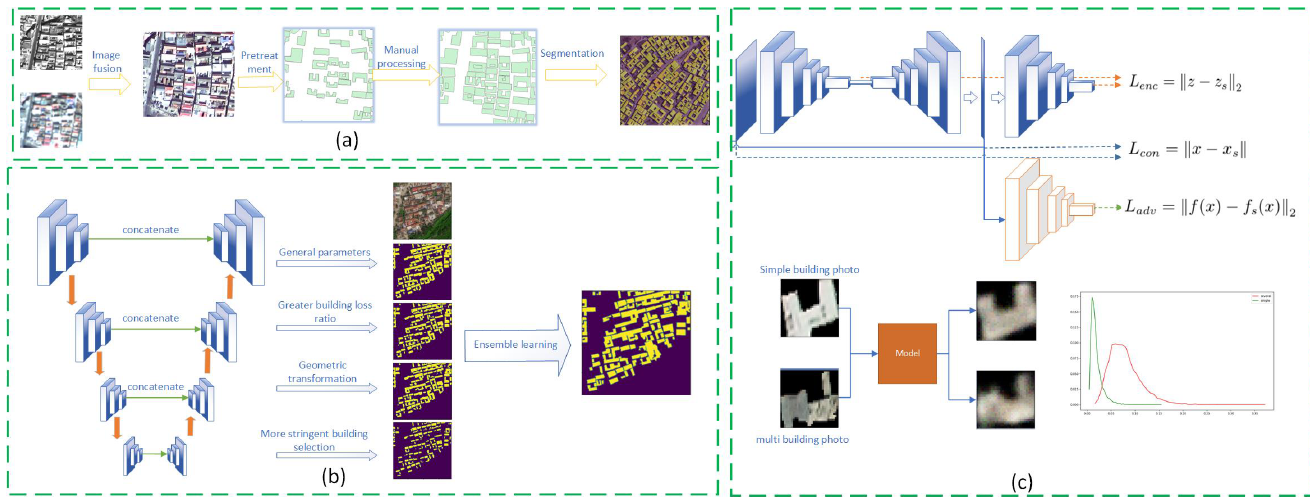
Figure 1. Overall structure;The meaning of each part is as follows:( a ) Image preprocessing and rapid sample construction; ( b ) Multi-model prediction and ensemble learning; ( c ) Building segmentation and